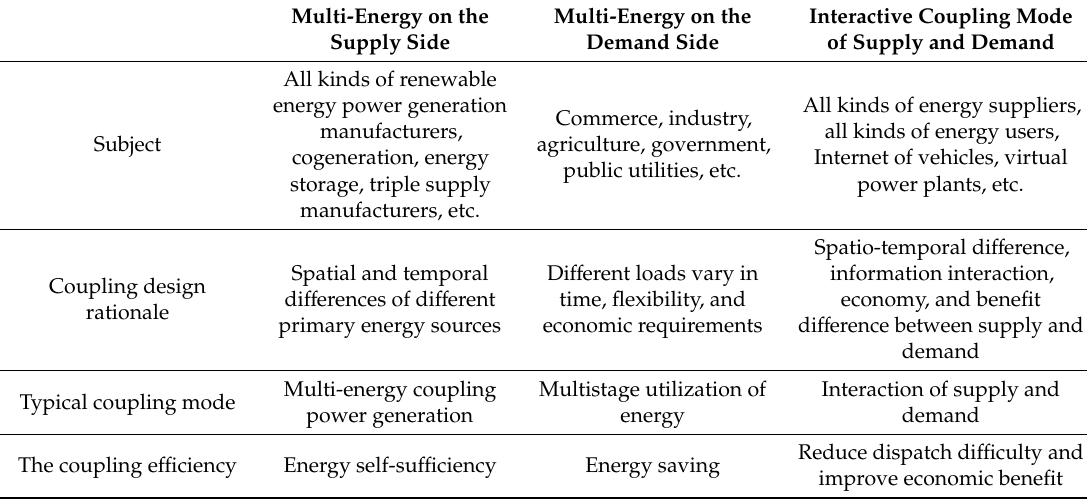
Table 2. Multi-energy coupling mechanism analysis.